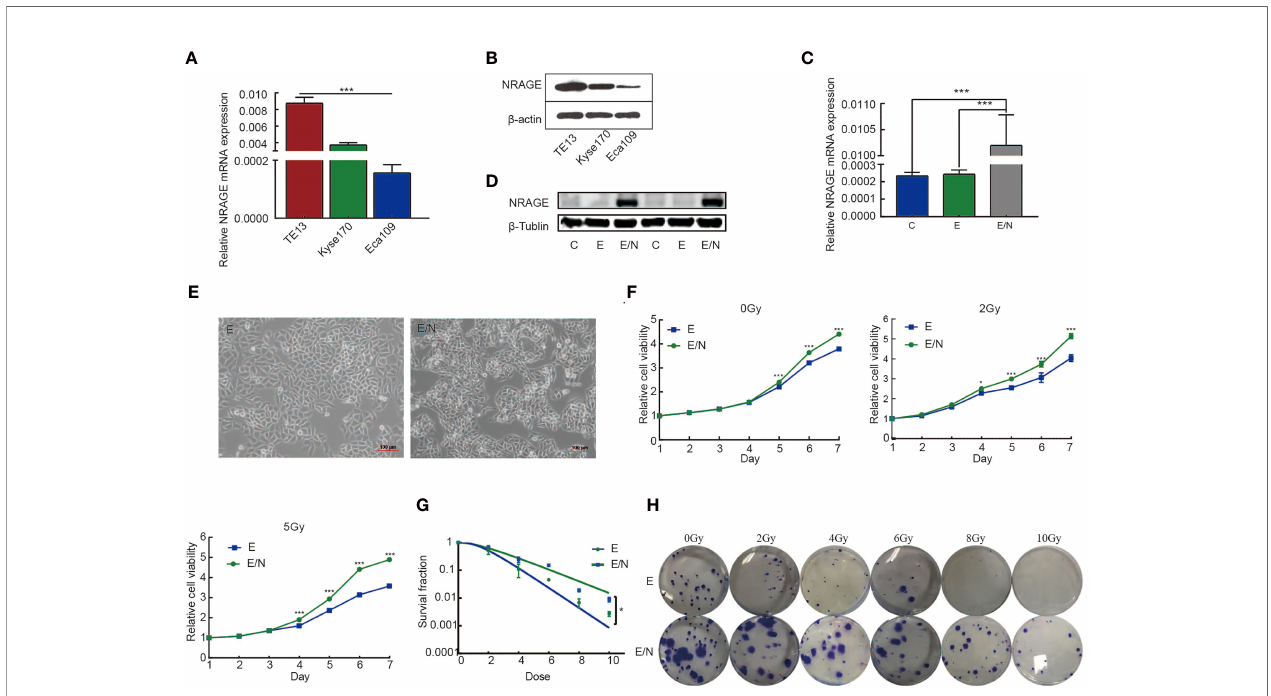
FIGURE 1 | Overexpression of NRAGE enhanced the proliferation and radioresistance of ESCC cells in 2D culture. (A) Quanti fi cation and analysis of NRAGE mRNA in different ESCC cell lines. (B) NRAGE protein levels were analyzed using western blotting in different ESCC cell lines. (C, D) Realtime PCR and Western blot assays to determine the overexpression ef fi ciency of transduced Eca109 cells (C: Eca109; E: Eca109-vector; E/N: Eca109-NRAGE); (E) cellular morphology compared between E and E/N cells; (F) growth curve was detected by CCK8 analysis upon NRAGE stable transfection followed by different irradiation doses with 0, 2 or 5 Gy; (G) Dose – response curves were fi tted according to the multi-target, single-hit model and analyzed using GraphPad Prism 8.0 software. (H) Representative images of colony formation of E and E/N cells after exposure to radiation. All data represented as means ± SD. * p < 0.05 vs. E; *** p < 0.001 vs.